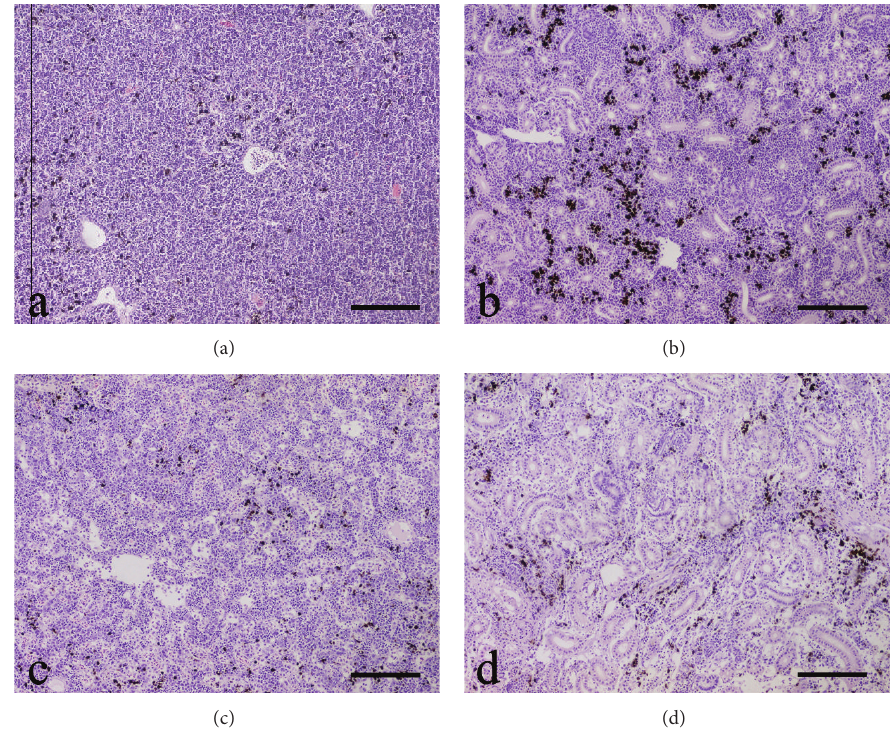
Figure 2: Rainbow trout ( Oncorhynchus mykiss ). Anterior (a) and posterior (b) kidney section, showing an extensive accumulation of macrophage aggregates (MA) in a normal trout from Ctrl group. Anterior (c) and posterior (d) kidney section, showing very few macrophages aggregates in a diseased trout from group C (H&E, scale bar = 200 𝜇